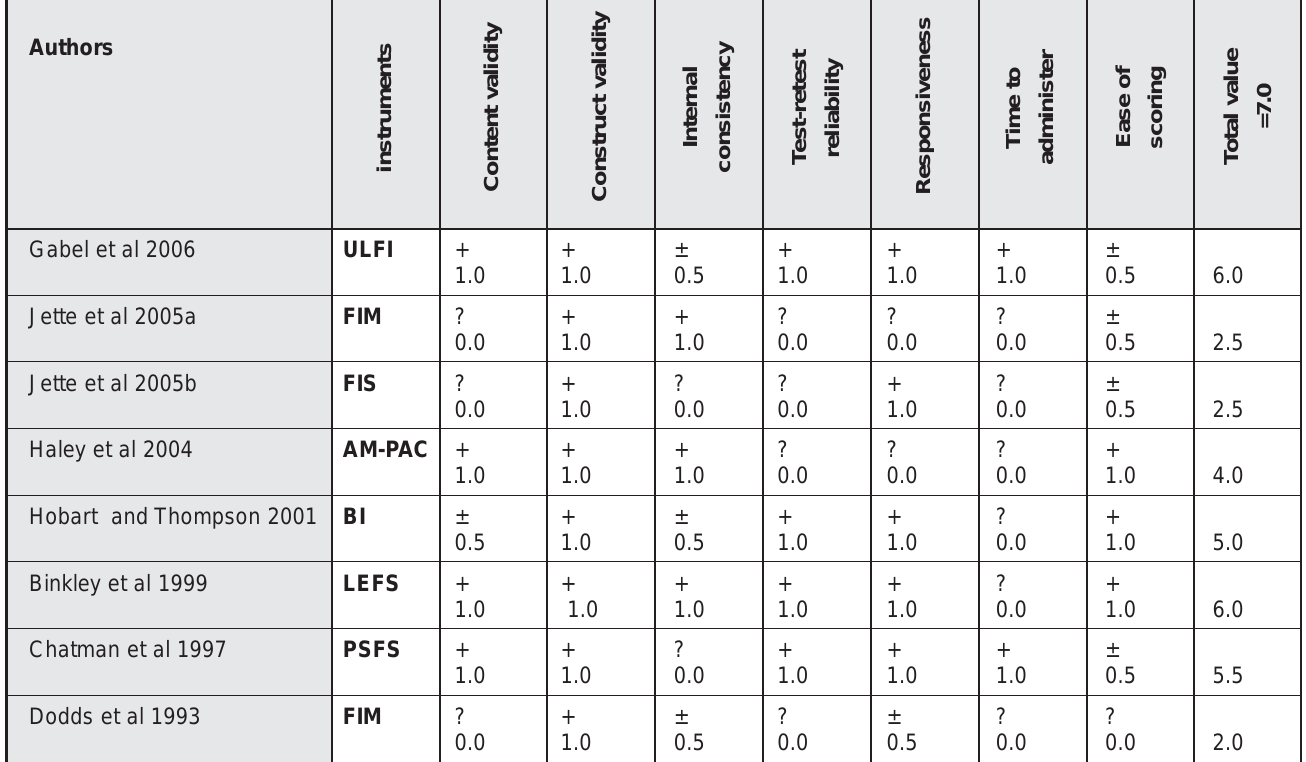
Table1: Summary of methodological critical appraisal Authors